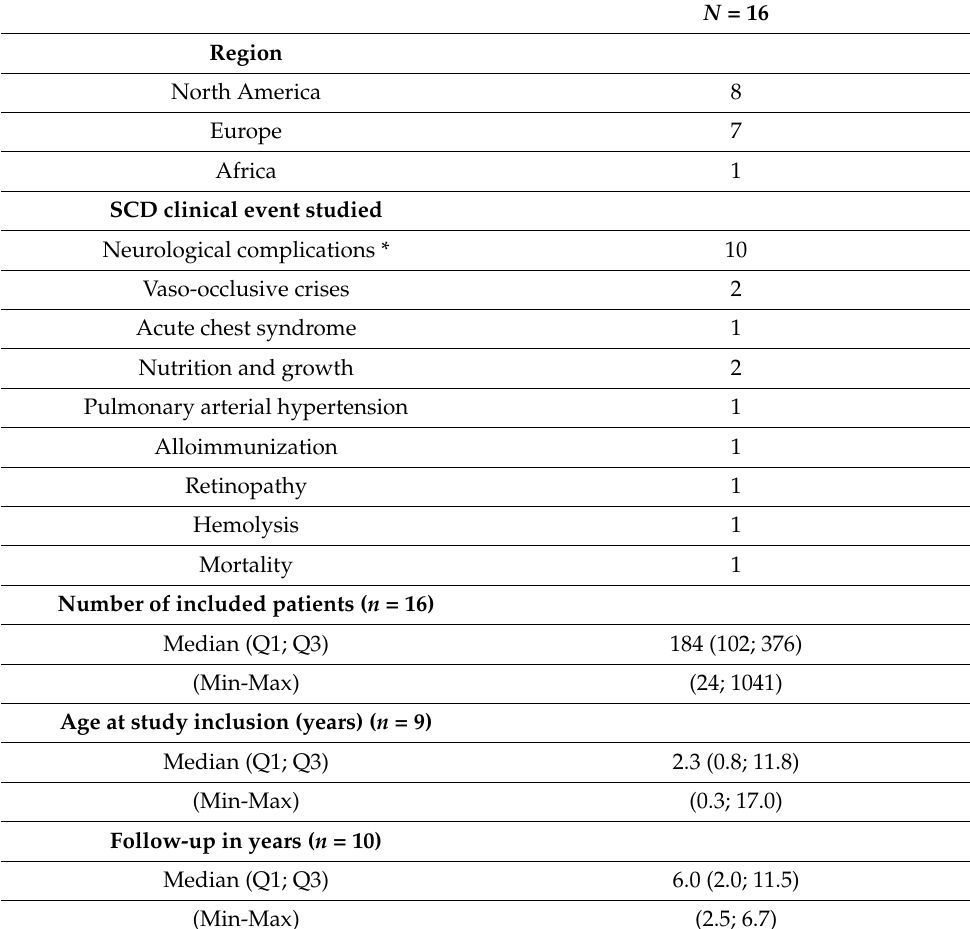
Table 1. Characteristics of the 16 sickle cell disease (SCD) cohort studies found by the literature search study